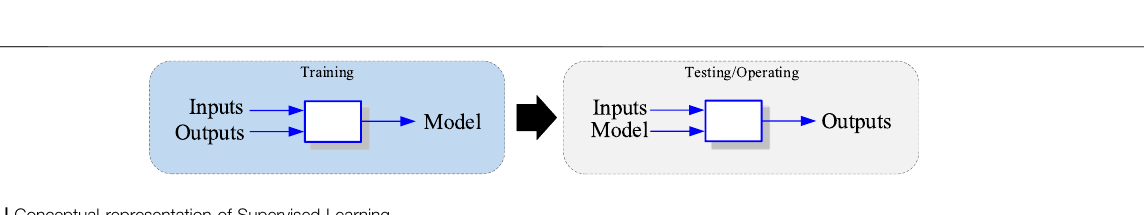
FIGURE 6 | Conceptual representation of Supervised